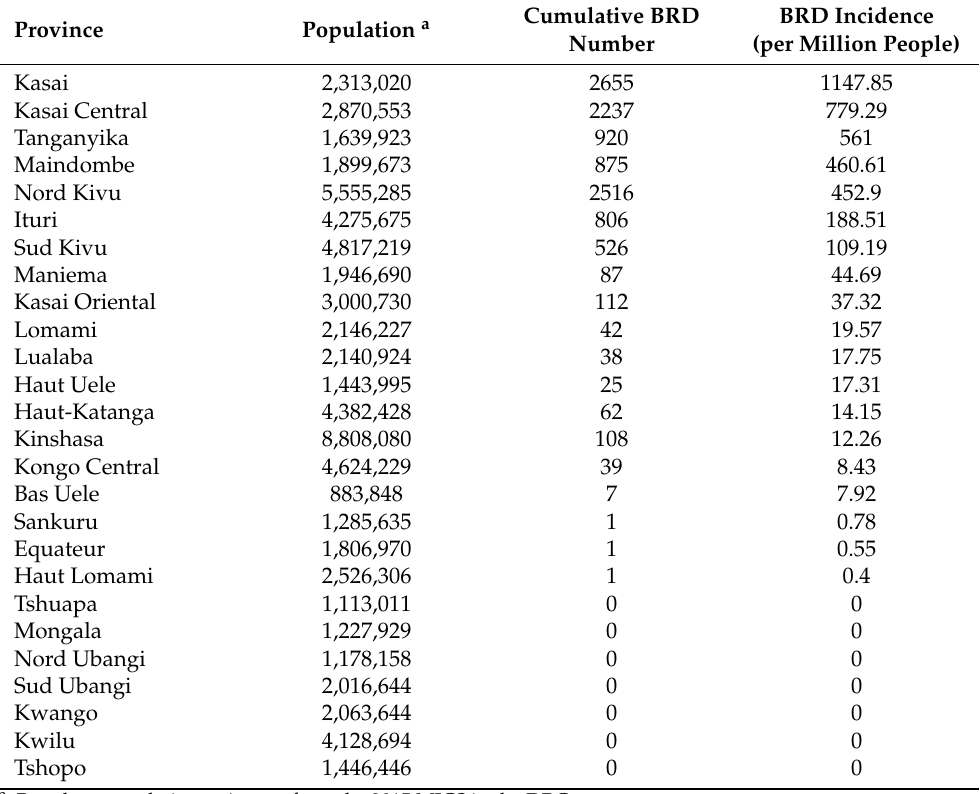
Table 1. Population and the incidence of battle-related deaths (BRD) of each province in the DRC